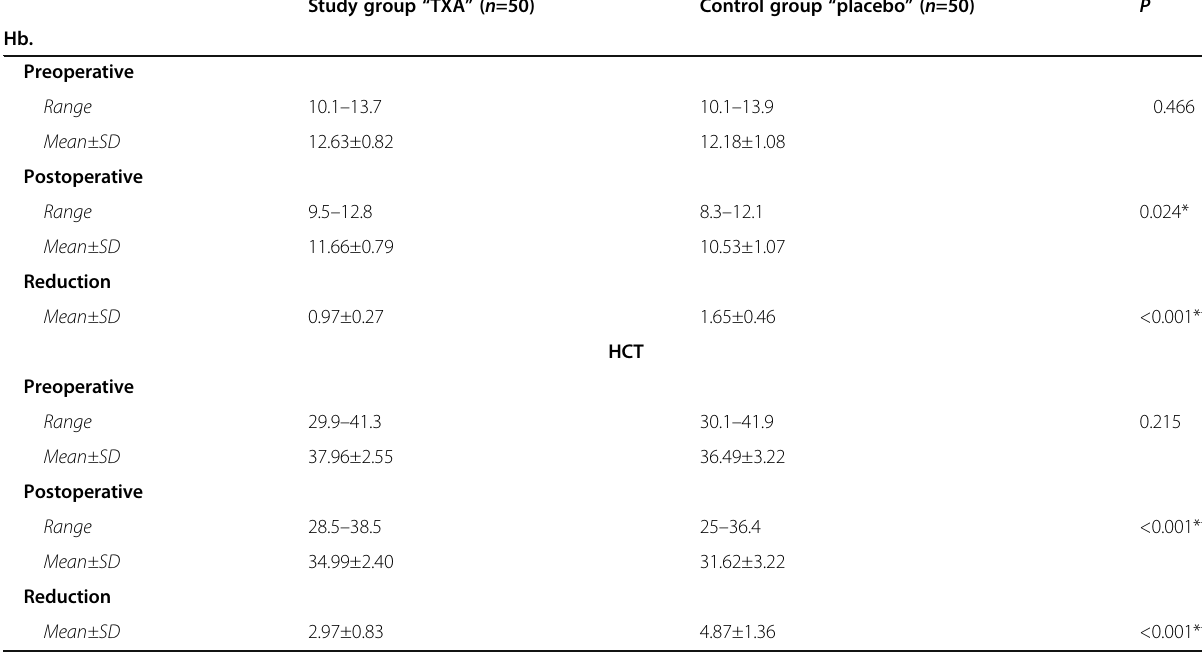
Table 2 Hemoglobin (Hb) and hematocrit (HCT) level